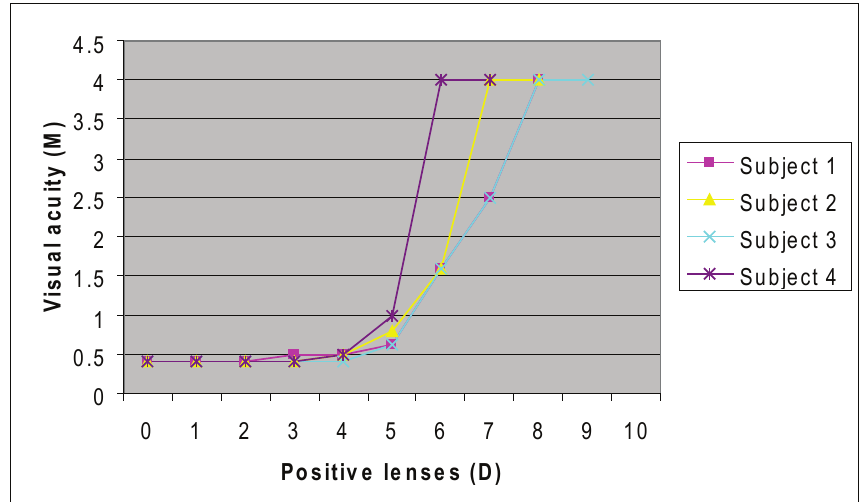
Figure 2. Effect of positive lenses on visual acuity while viewing a near acuity chart at 0.4 m through a pinhole with a 1.5 mm diameter and illumination of 460 lux.